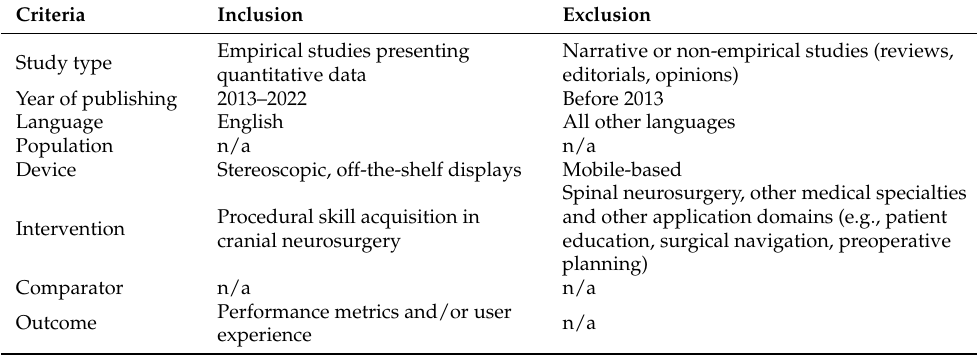
Table 1. Eligibility criteria. Summary of criteria for inclusion of studies in the present review, based on relevant attributes and the PICO (population, intervention, comparators, outcome)